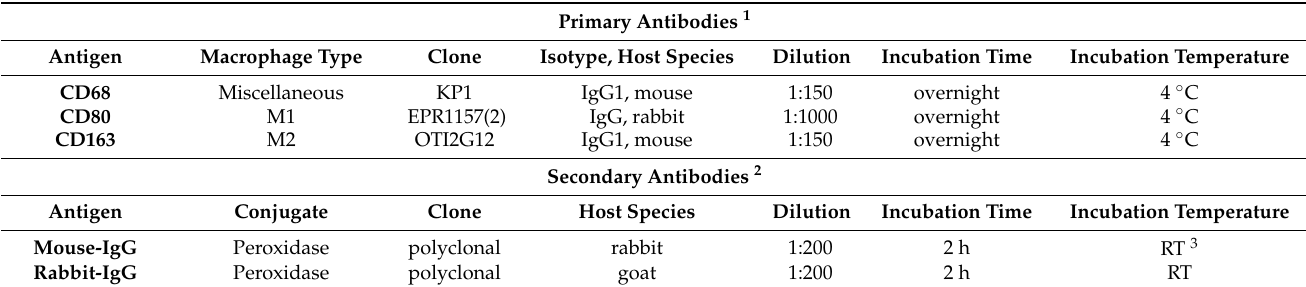
Table 3. Unconjugated primary as well as secondary antibodies for immunohistochemical stainings of human liver tissue sections. Summary of antibodies including antigen, conjugate, macrophage type, clone, isotype and host species, dilution, as well as incubation time and